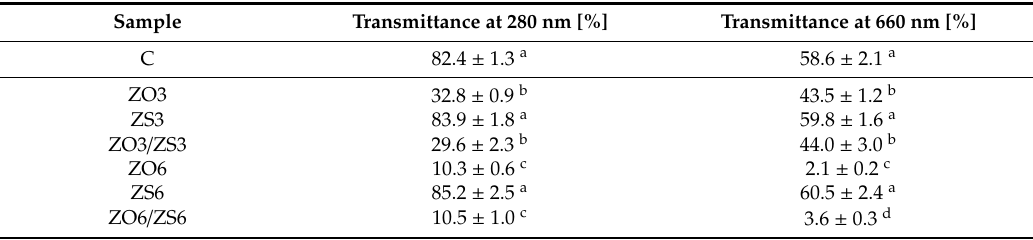
Table 2. Comparison of the optical properties of PE films containing a masterbatch with zinc oxide (ZO) and / or zinc stearate (ZS) ( n = 3, p <